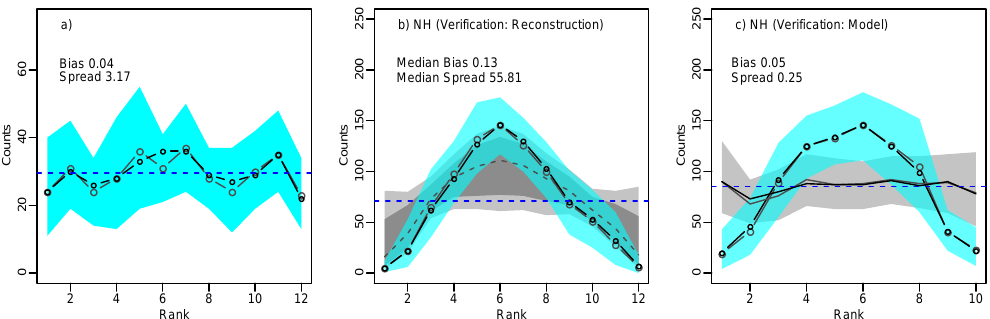
Fig. 4. Evaluation of probabilistic consistency: rank histogram counts (black line with points) for temperature data: (a) SIM against Central European annual temperature target, (b) SIM against Northern Hemisphere temperature target, (c) FRS against Northern Hemisphere tem- perature target. Analysis does include the uncertainties in the target. Numbers are χ 2 statistics accounting for auto-correlation. In (b) they are the median relative to all representations of ensemble-mean reconstruction plus internal variability estimate; in (c) they are relative to the ensemble-mean simulation plus internal variability estimate. Cyan shading (grey lines with points) is 0.5% and 99.5% (50%) quantiles for block-bootstrapped rank histograms (2000 replicates, block length of 50yr) relative to raw targets. Light grey shading and dashed line in (b) are equivalent quantiles for the various estimates of internal variability, dark grey shading adds 5% and 95% quantiles. In (c) black continuous line is rank count relative to the ensemble-mean target with added internal variability estimate. Grey shading and continuous line add bootstrapped 0.5% and 99.5% and 50% quantiles. Blue horizontal lines give the expected average count for a perfectly uniform histogram. Single test critical values are 2.706 for a χ 2 distribution with one degree of freedom (see Sect. 2.1 and Jolliffe and Primo, 2008; Annan and Hargreaves, 2010) and a conservative one-sided 90%